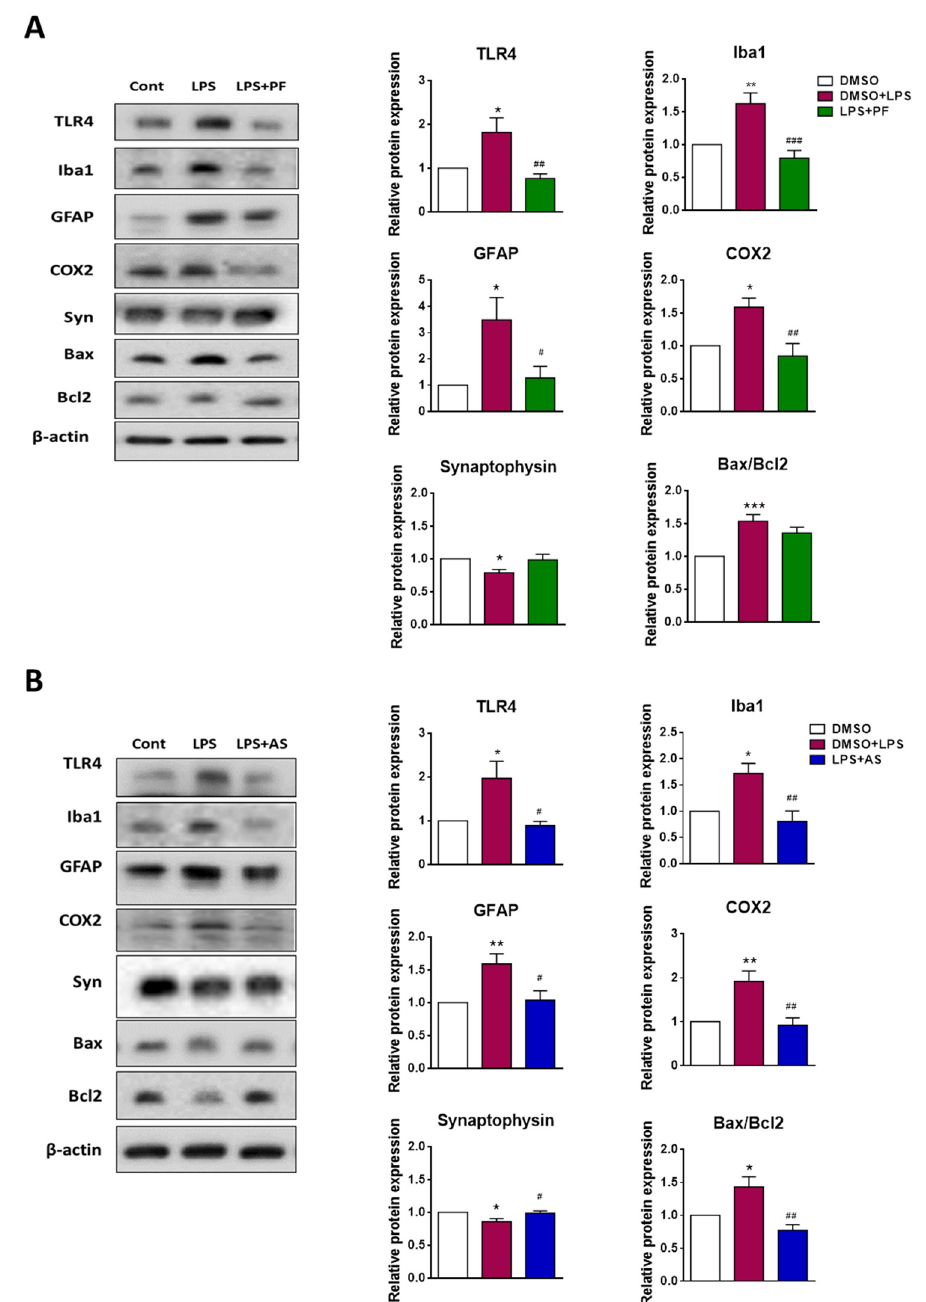
Figure 9. Inhibition of ATX and LPA5 regulates proteins involved in neuroinflammation in LPS-injected C57Bl/6 mice. Mice (n = 6–8 per group) were injected intraperitoneally (i.p.) with DMSO, LPS (5 mg/kg) plus DMSO, with or without ( A ) PF8380 (‘PF’; 30 mg/kg) or ( B ) AS2717638 (‘AS’; 10 mg/kg). After 24 h, the animals were sacrificed and the brains were perfused. The left hemisphere from each mouse was processed for protein analyses by immunoblotting. Protein expression of TLR4, Iba1, GFAP, COX2, synaptophysin, Bax, and Bcl2 were monitored by Western blot analyses. β -actin was used as loading control. One representative blot for each protein is shown. Densitometric evaluation of immunoreactive bands is shown in the bar graphs. Values are expressed as mean ± SEM of 6–8 mice per group (* p < 0.05, ** p < 0.01, *** p < 0.001 compared to DMSO control; # p < 0.05, ## p < 0.01, ### p < 0.001 compared to LPS-treated mice; one-way ANOVA with Bonferroni correction).